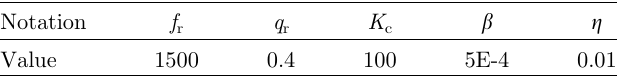
Table 2. Digital sound synthesis parameters pertaining to reed dynamics. All unitless except f r , in Hz.